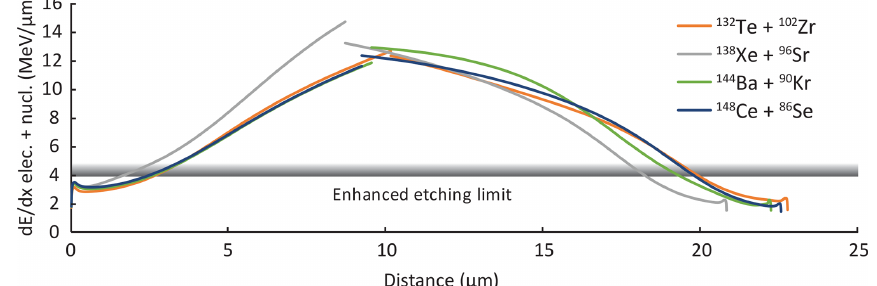
Figure 1. Energy loss profiles from electronic and nuclear interactions for a sampling of possible products from induced fission of 235 U in apatite calculated using SRIM (Ziegler, 2013). For each fission pair, the left curve segment is the heavier, lower-energy fragment. The shaded horizontal line represents the approximate limit below which energy loss no longer results in enhanced etching